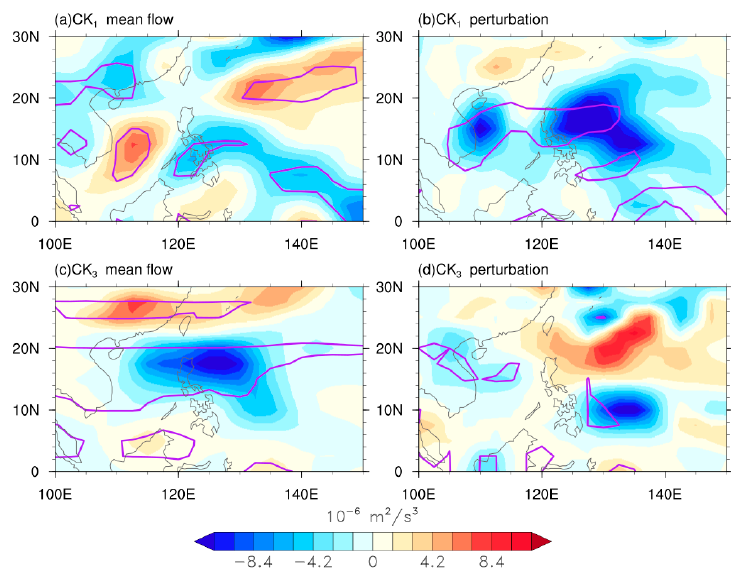
Figure 6. Contribution of perturbation and June mean flow components to the difference in 𝐶𝐾 (cid:2869) and 𝐶𝐾 (cid:2871) : ( a ) considers the anomalous zonal gradient of June mean zonal wind only and ( b ) considers the turbulence flux 𝑢 (cid:4593)(cid:2870) anomaly only; ( c , d ) are similar to ( a , b ), but ( c ) considers the anomalous meridional gradient of June mean zonal wind only and ( d ) considers the turbulence flux 𝑢′𝑣′ anomaly only. Purple contours indicate p -level of 0.05.